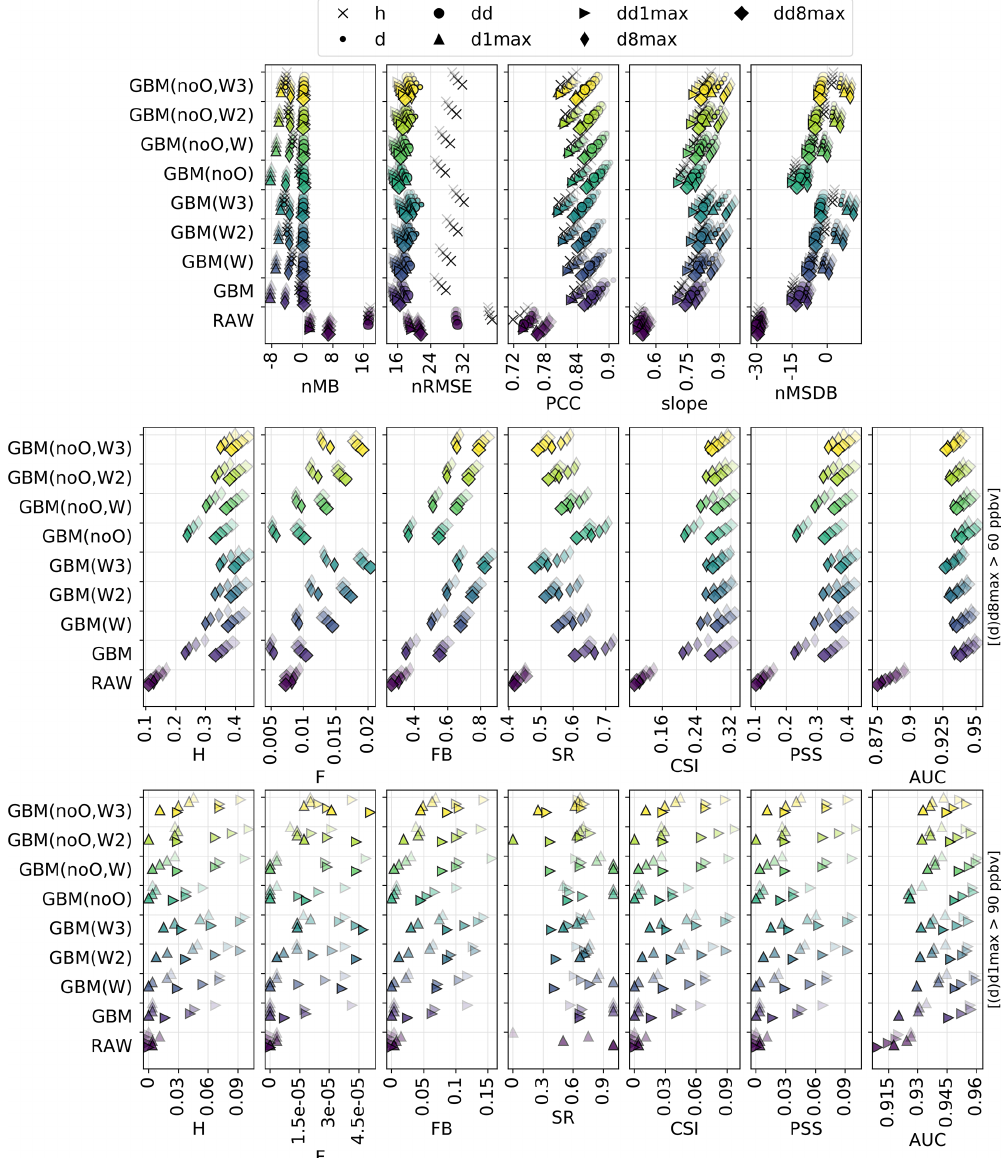
Figure G5. Similar to Fig. 3 for sensitivity tests on the GBM method.